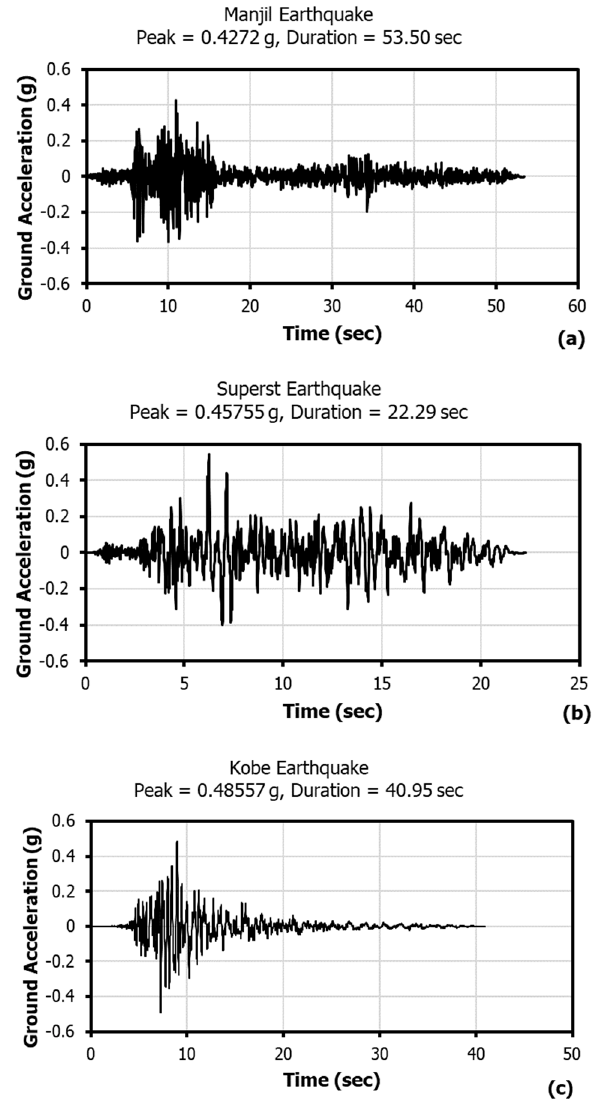
Figure 8. Earthquake input data for the Shaking Table Test; ( a ) Manjil earthquake; ( b ) Superstition Hills earthquake; ( c ) Kobe earthquake.